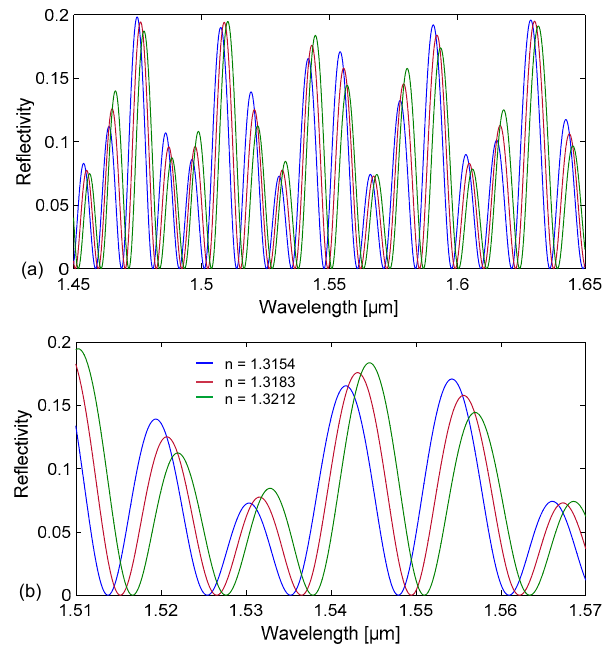
Figure 6. Calculated reflectivity spectra R( λ ) = P r ( λ )/P in ( λ ) for a rectangular–miniature hollow glass tubing with d = 30 µm,t f = t b = 21 µm (nominal dimensions) considering three different values of refractive index for the filling fluid: ( a ) spectra in the wavelength range 1.45–1.65 µm; ( b ) zoom in the range 1.51–1.57 µm.